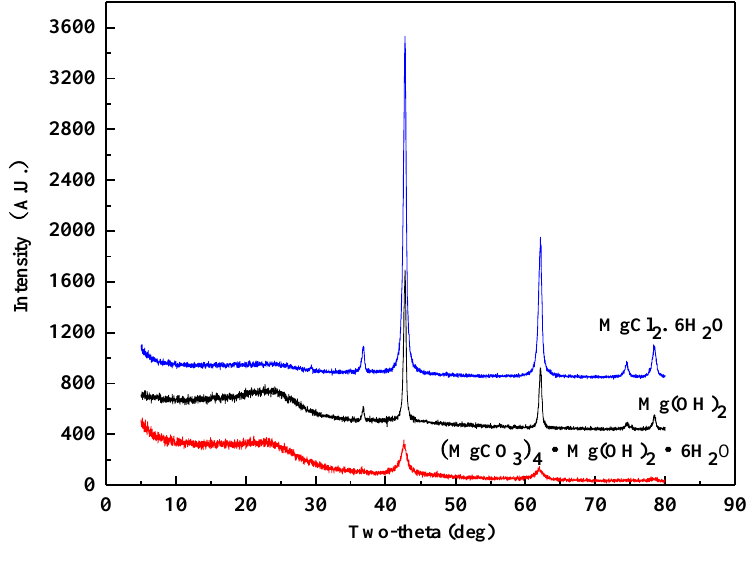
Figure 3. XRD patterns of treated red gm wood after being calcined at 500 °C